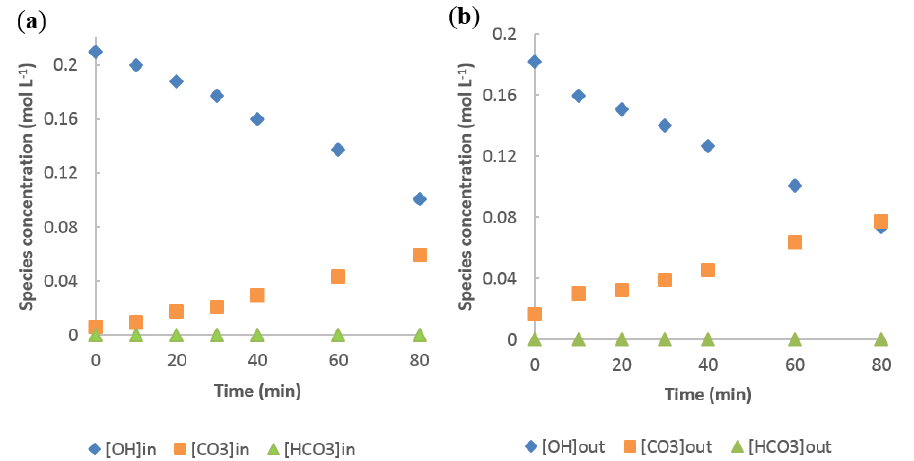
Figure 3. Evolution of inlet ( a ) and outlet ( b ) species concentration as a function of time in the membrane contactor. CO 2 and NaOH initial concentrations are 10% and 0.2 mol L −1 , respectively; gas and liquid flow rates are 6.5 and 1 L min −1 ; respectively.